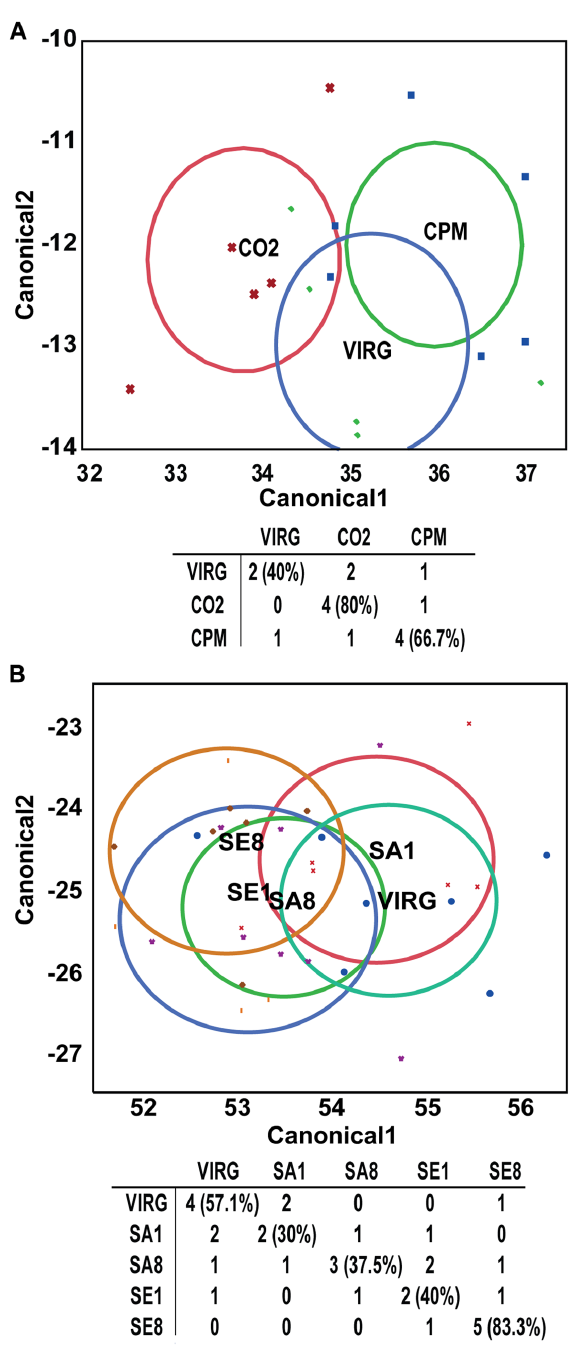
Figure 3. Linear discriminant analysis of QMP components. The relative proportions of the individual compounds found in the mandibular glands of the queens in experiments 1 and 2 were arcsine square root transformed and subjected to linear discriminant analysis. A ) Discriminant plot with classification of Virg, CO 2 and CPM queen groups and the table of actual (rows) by predicted (columns) numbers of queens in different groups. Symbols represent individual queens; circle represents the 95% confidence region containing the true mean. B ) Discriminant plot with classification of Virg, SA1, SA8, SE1, and SE8 queen groups and the table of actual (rows) by predicted (columns) numbers of queens in the different groups. Numbers in parentheses represent the percentage of queens classified